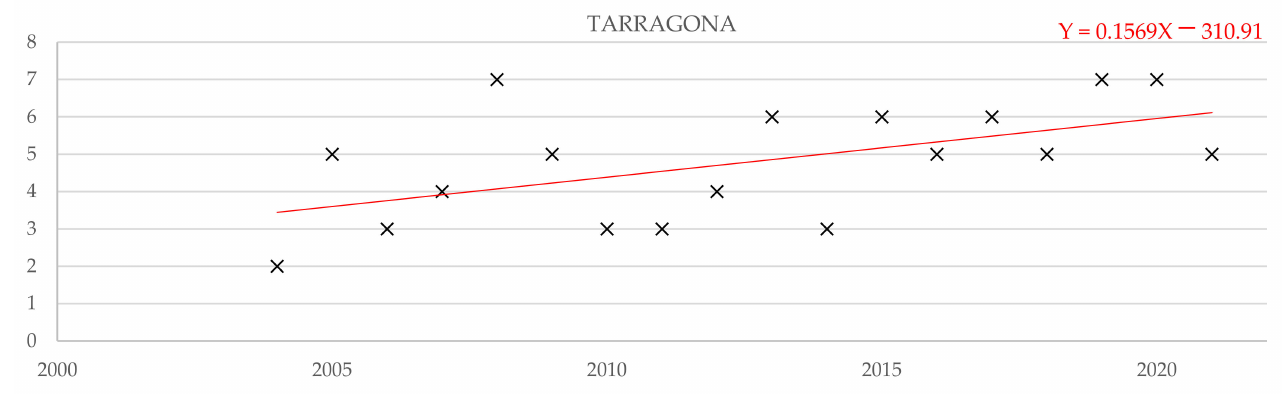
Figure 25. Number of times Hs has exceeded the threshold in